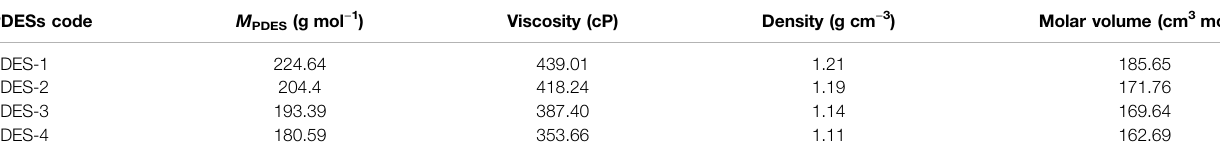
TABLE 2 | Physical properties of the PDESs.